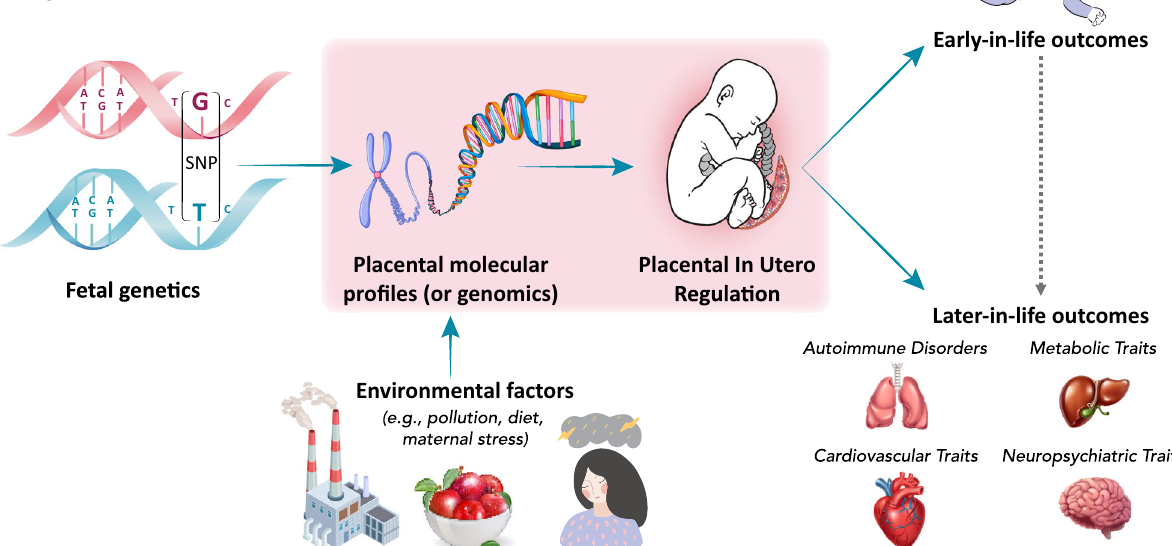
Fig. 1 Overview of the DOHaD hypothesis. The placenta facilitates important functions in utero, including nutrient transfer, metabolism, gas exchange, neuroendocrine signaling, growth hormone production, and immunologic control. Accordingly, it is a master regulator of the intrauterine environment and is core to the Developmental Origins of Health and Disease (DOHaD) hypothesis. Placental genomic regulation is in fl uenced by both genetic and environmental factors and affects placental developmental programming. In turn, this programming has been shown to have profound impacts on a variety of disorders and traits, both early- and